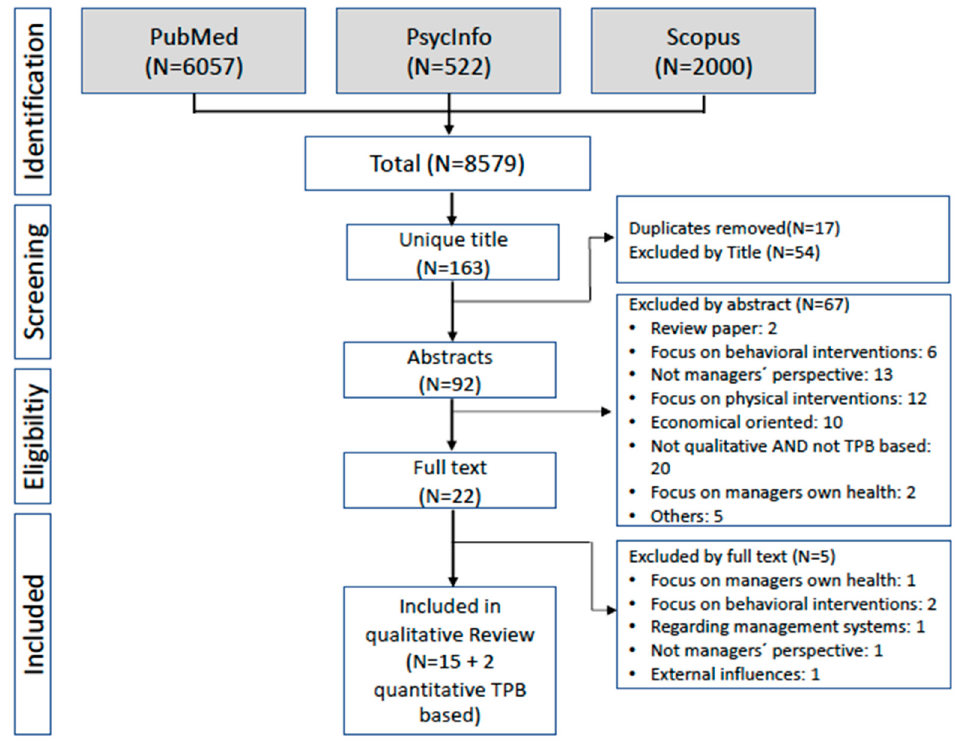
Figure 1. PRISMA flowchart demonstrating search strategy.